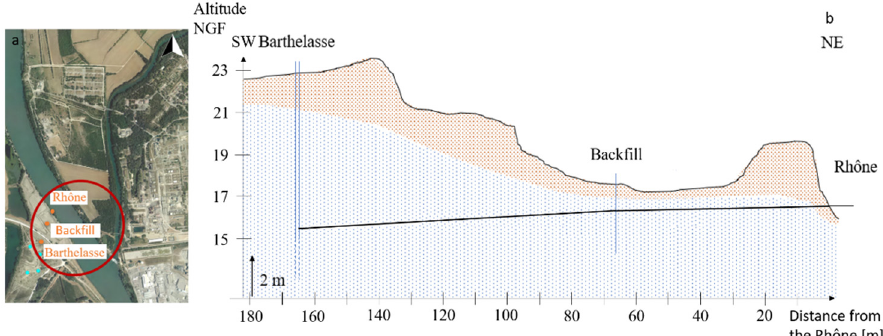
Figure 5. Monitoring network of physico-chemical parameters using various sensors and the water sampling network set up on Barthelasse Island ( a ) and cross-section of the Rhône/Girardon unit/Barthelasse transect ( b ).